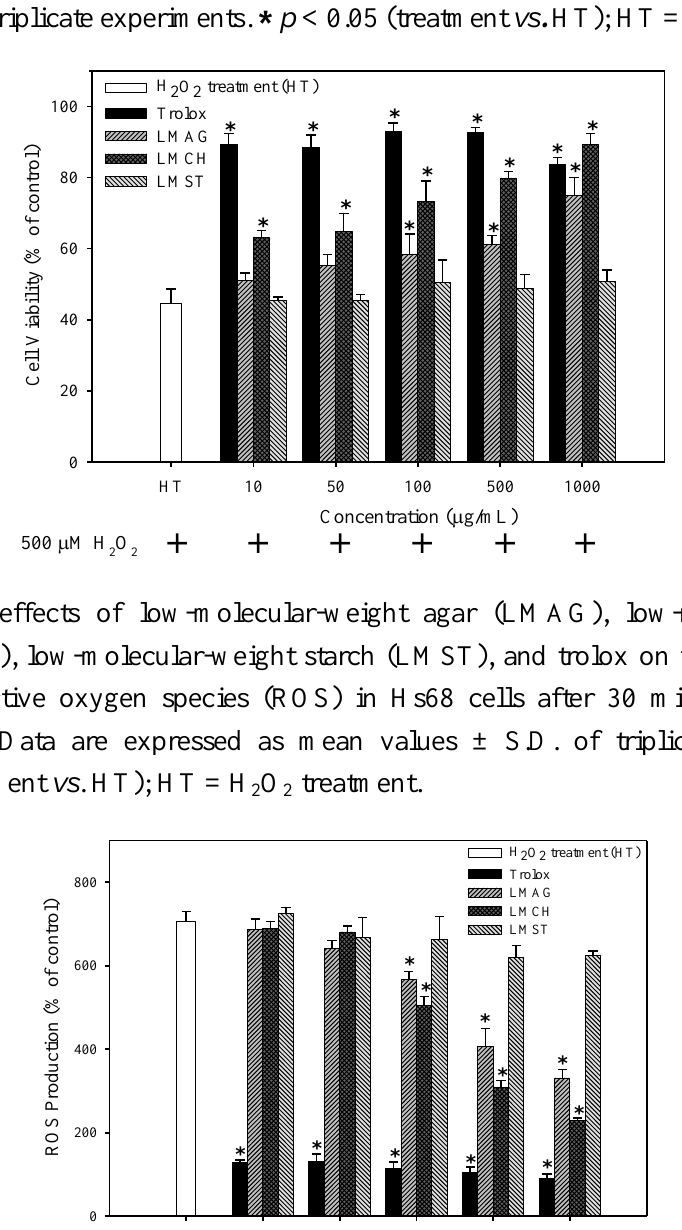
Figure 2. The effects of low-molecular-weight agar (LMAG), low-molecular-weight chitosan (LMCH), low-molecular-weight starch (LMST), and trolox on the viability of Hs68 cells in response to 24 h treatment with 500 μM H values ± S.D. of triplicate experiments. * p < 0.05 (treatment vs. HT); HT = H